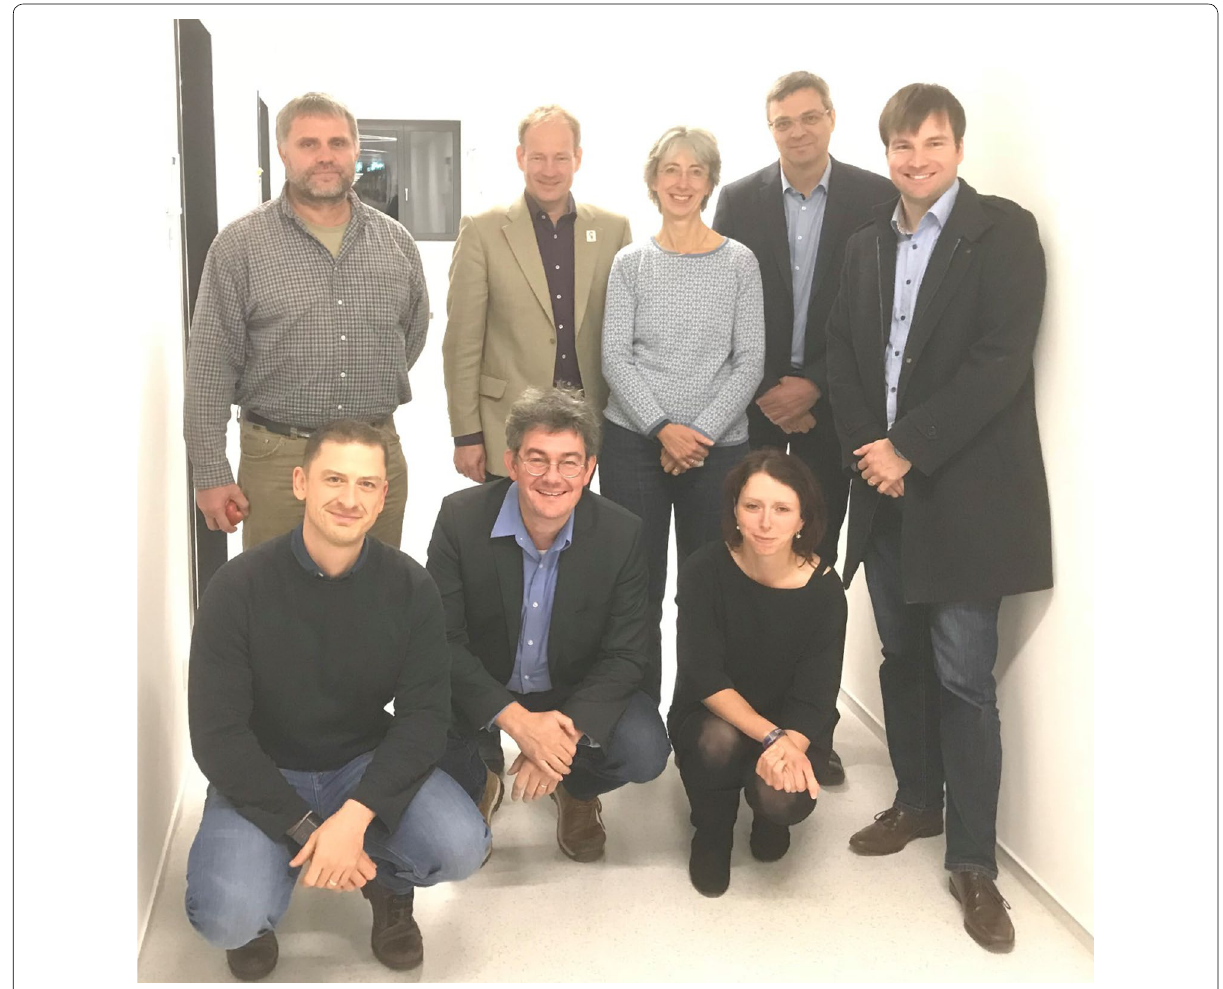
Fig. 1 Board of SETAC GLB in 2017